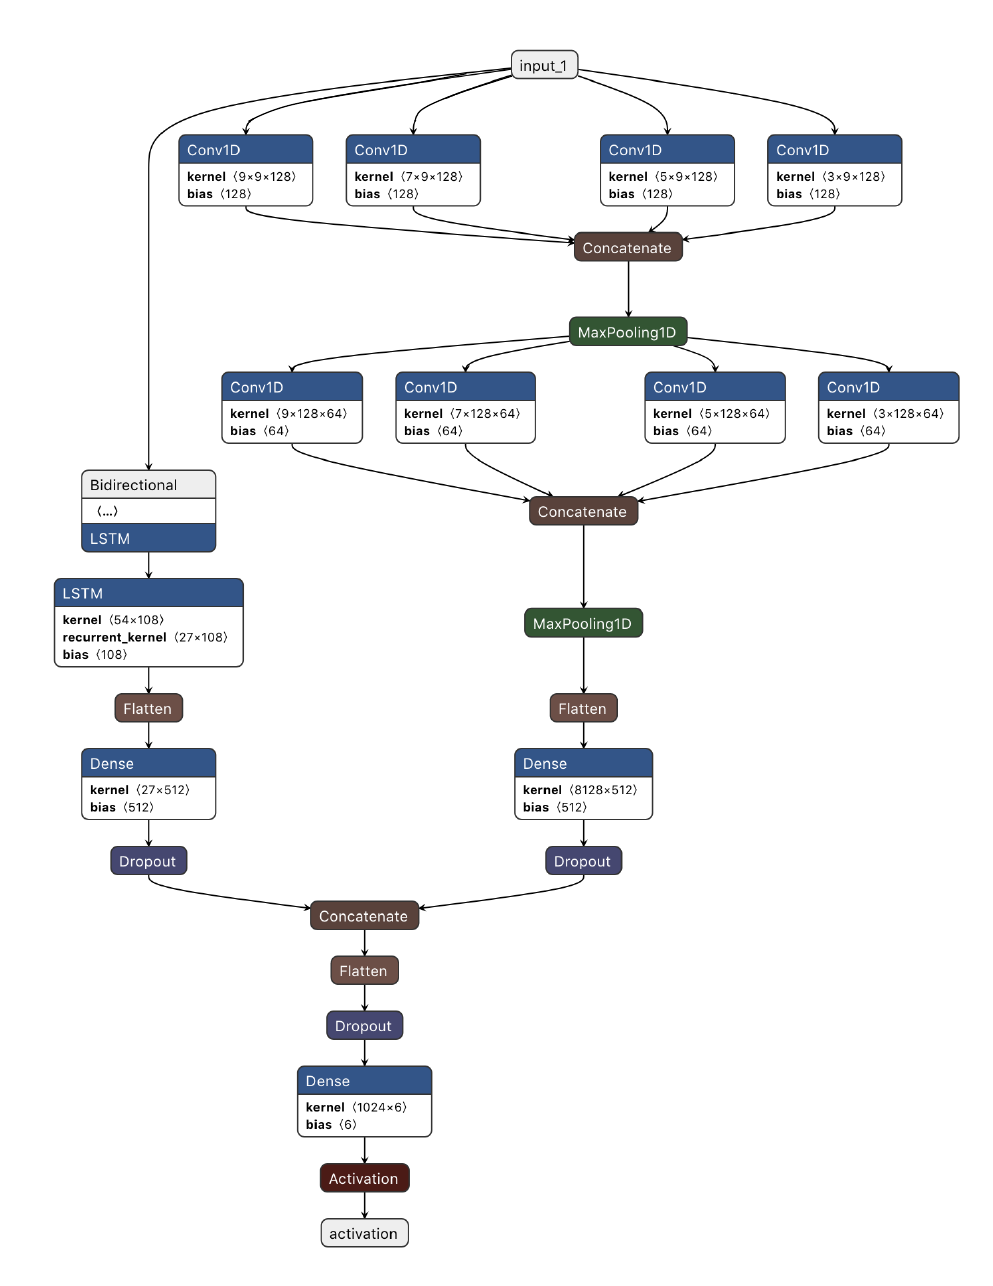
Figure 5. A detailed description of the proposed